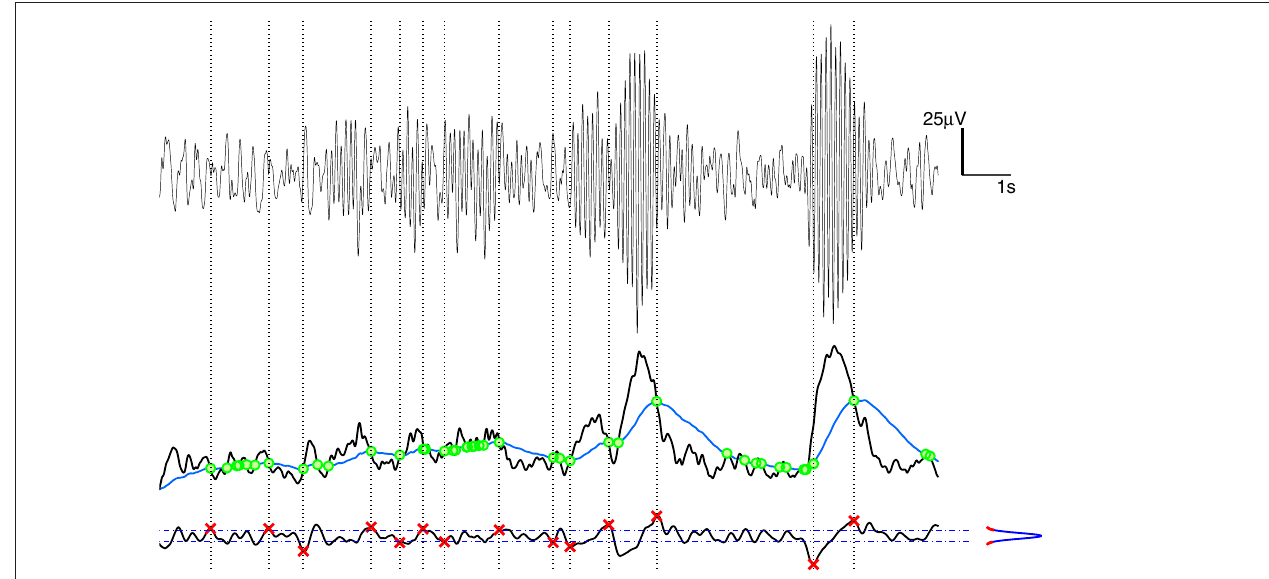
on text) of the TS ; the blue/red curve on the right denotes the distribution density of the derivatives, with the blue part denoting the central part,